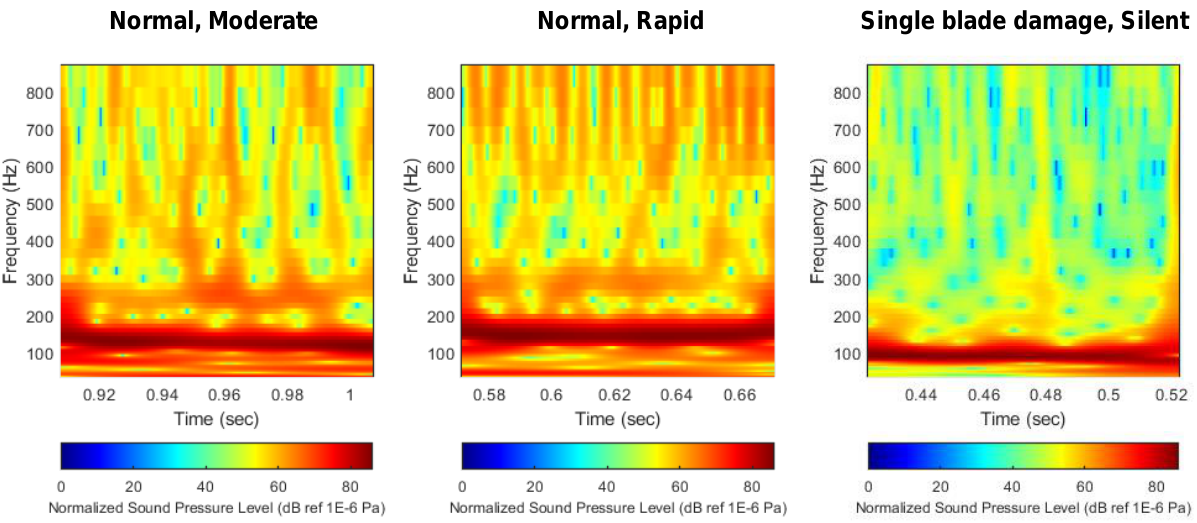
Figure 15. Flow noise scalogram for off-training condition with normalized decibel scale. ( left ) Normal–moderate; ( middle ) normal–rapid; ( right ) single-blade